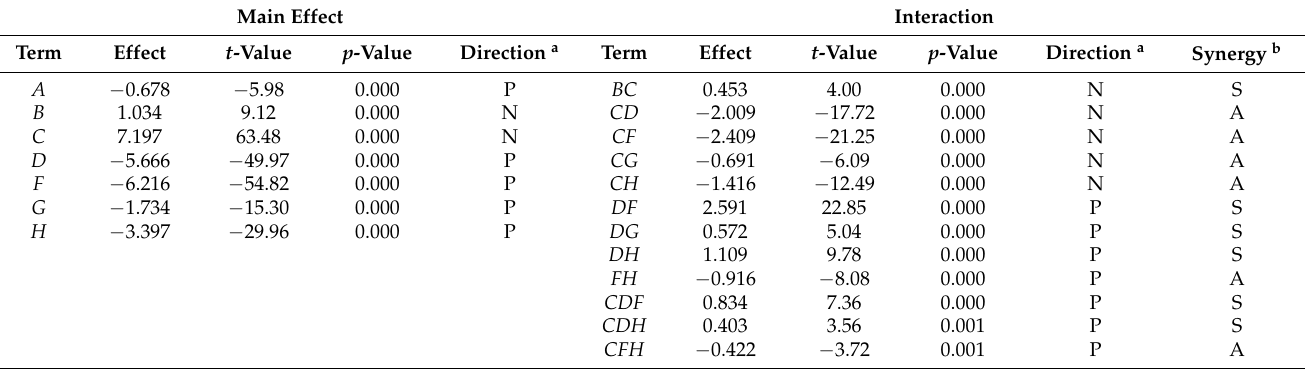
Table A3. The significant main effects and interactions of the pressure difference at elevator door (21st